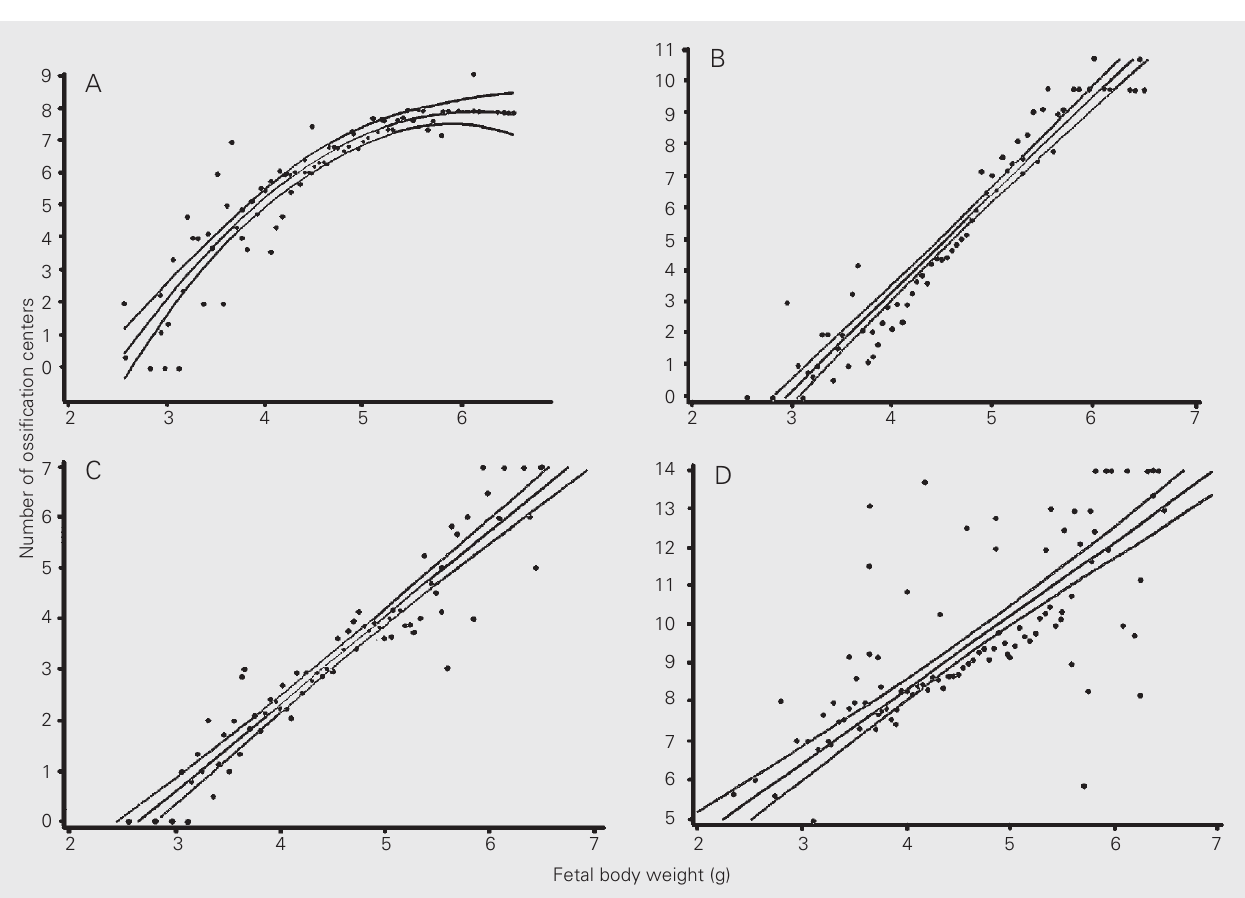
Figure 2. Relationship between fetal body weight (g) on pregnancy day 21 and extent of ossification (number of ossification centers) of proximal and medial phalanges of fore- (panel A) and hindpaws (panel B), as well as cervical vertebrae (panel C) and sacrococcygeal vertebrae (panel D). Regression lines are shown with their respective 95% confidence limits. Quadratic regression models were used for fore- and hindpaw phalanges (A and B) and linear regression was used for cervical and sacrococcygeal veterbrae (C and D). Correlation coefficients were 0.88, 0.97, 0.95, and 0.90 for A, B, C, and D, respectively. Data were for 1484 fetuses (154 litters) from untreated